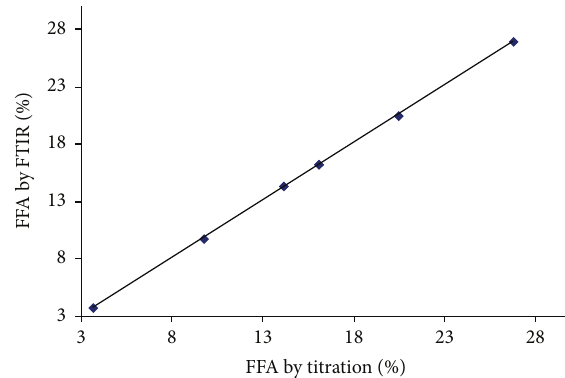
Figure 5: Correlation plot of mean AOCS titrimetric method versus SB-ATR FTIR predicted